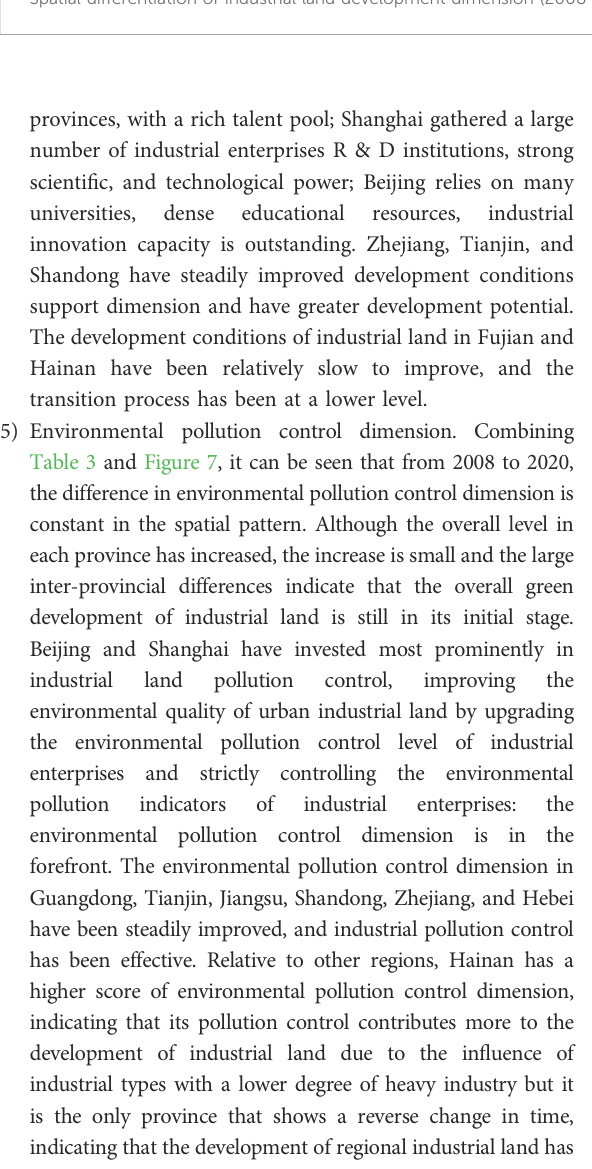
FIGURE 3 Spatial differentiation of industrial land development dimension (2008 and